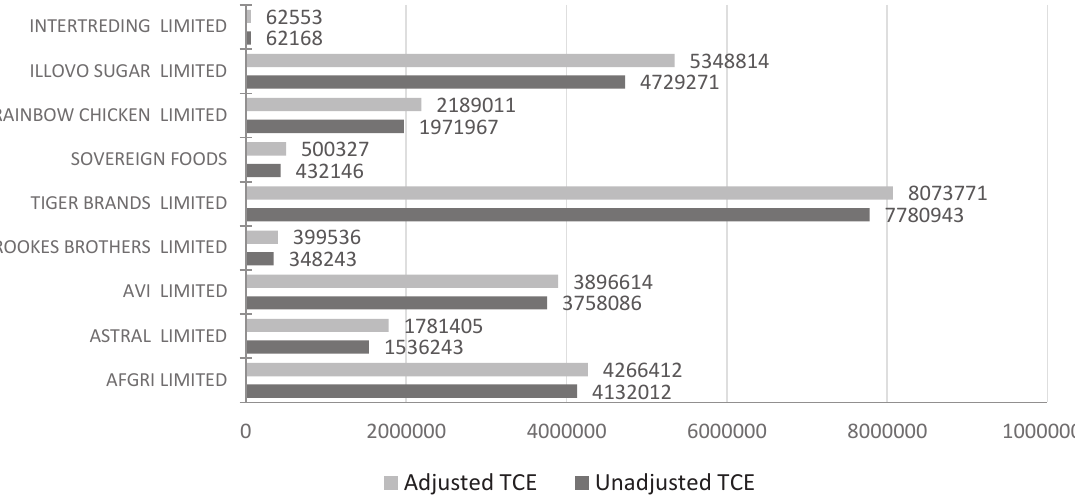
Figure 4. The unadjusted TCE and the adjusted TCE (Rand values in